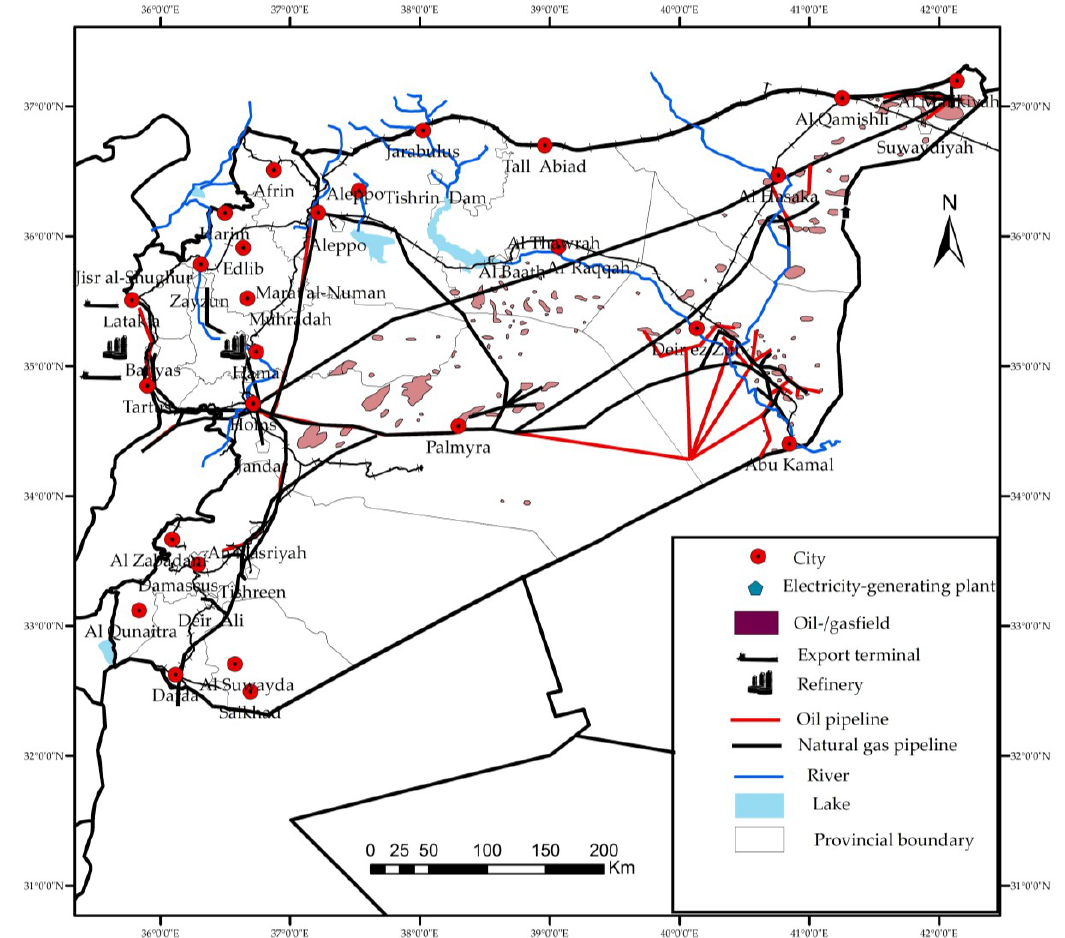
Figure 2. Geographical distribution of oil and natural gas deposits, refineries and pipelines.